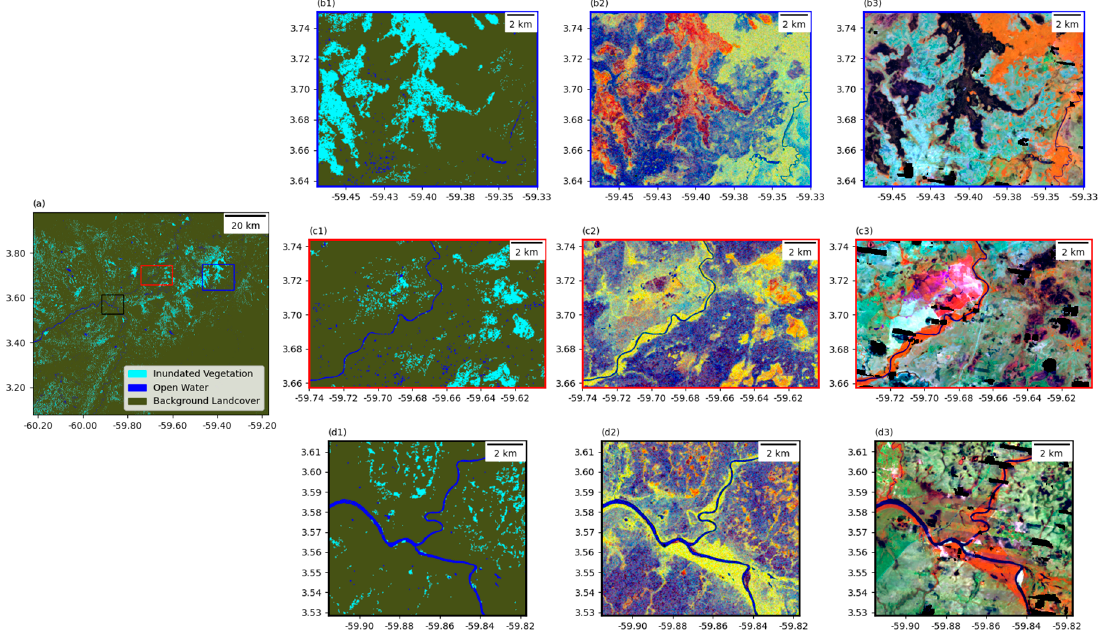
Figure 9. Example of RadWet wet season classified output over the North Rupununi dated 2 October 2020 ( a ). Subset figures represent the RadWet classified output, at representative locations including Sentinel-1 imagery used for the classification, and reference Sentinel-2 optical image. Specifically, ( b1 – b3 ) covers a section ofAmoko Lake; ( c1 – c3 ) shows the Irend River, including agricultural land anmd seasonally inundated savannah; and ( d1 – d3 ) is the location of the confluence of the Takutu and Irend Rivers